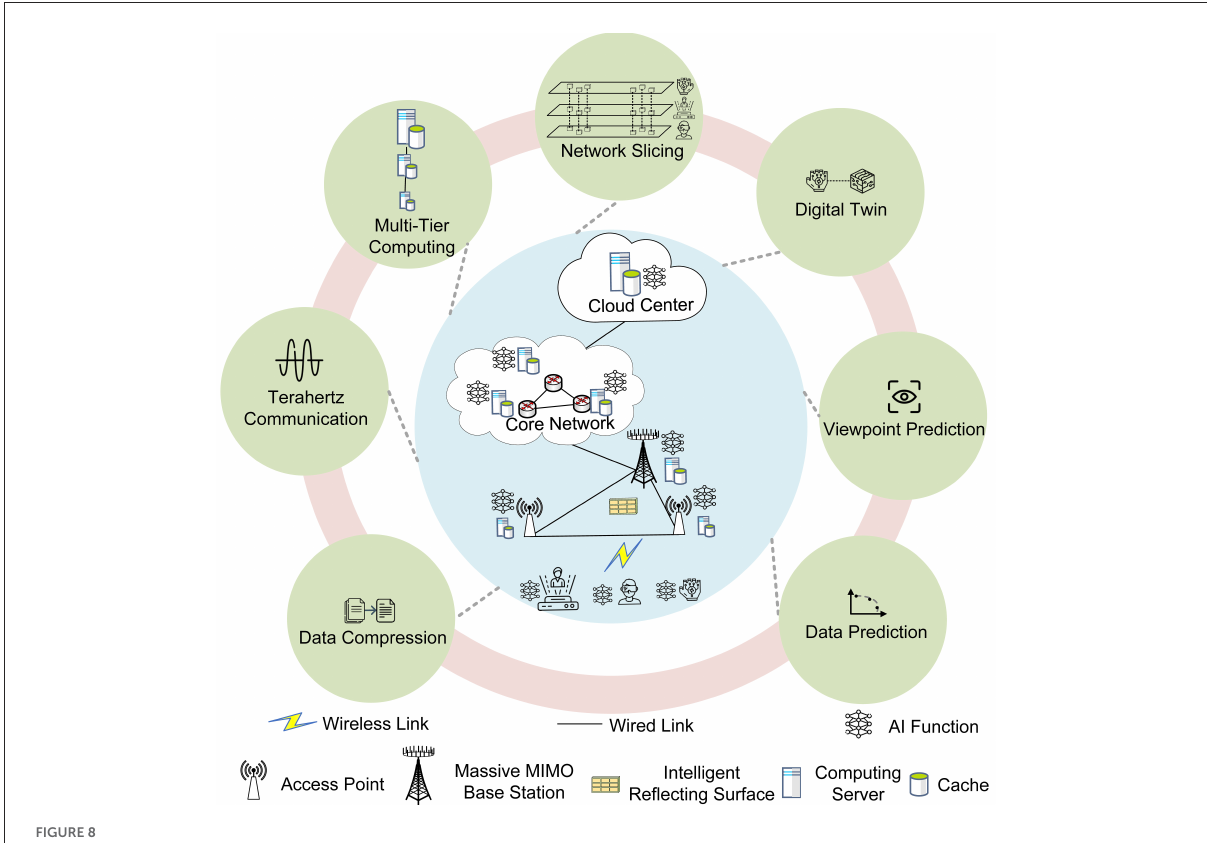
FIGURE8 Potential solutions to immersive